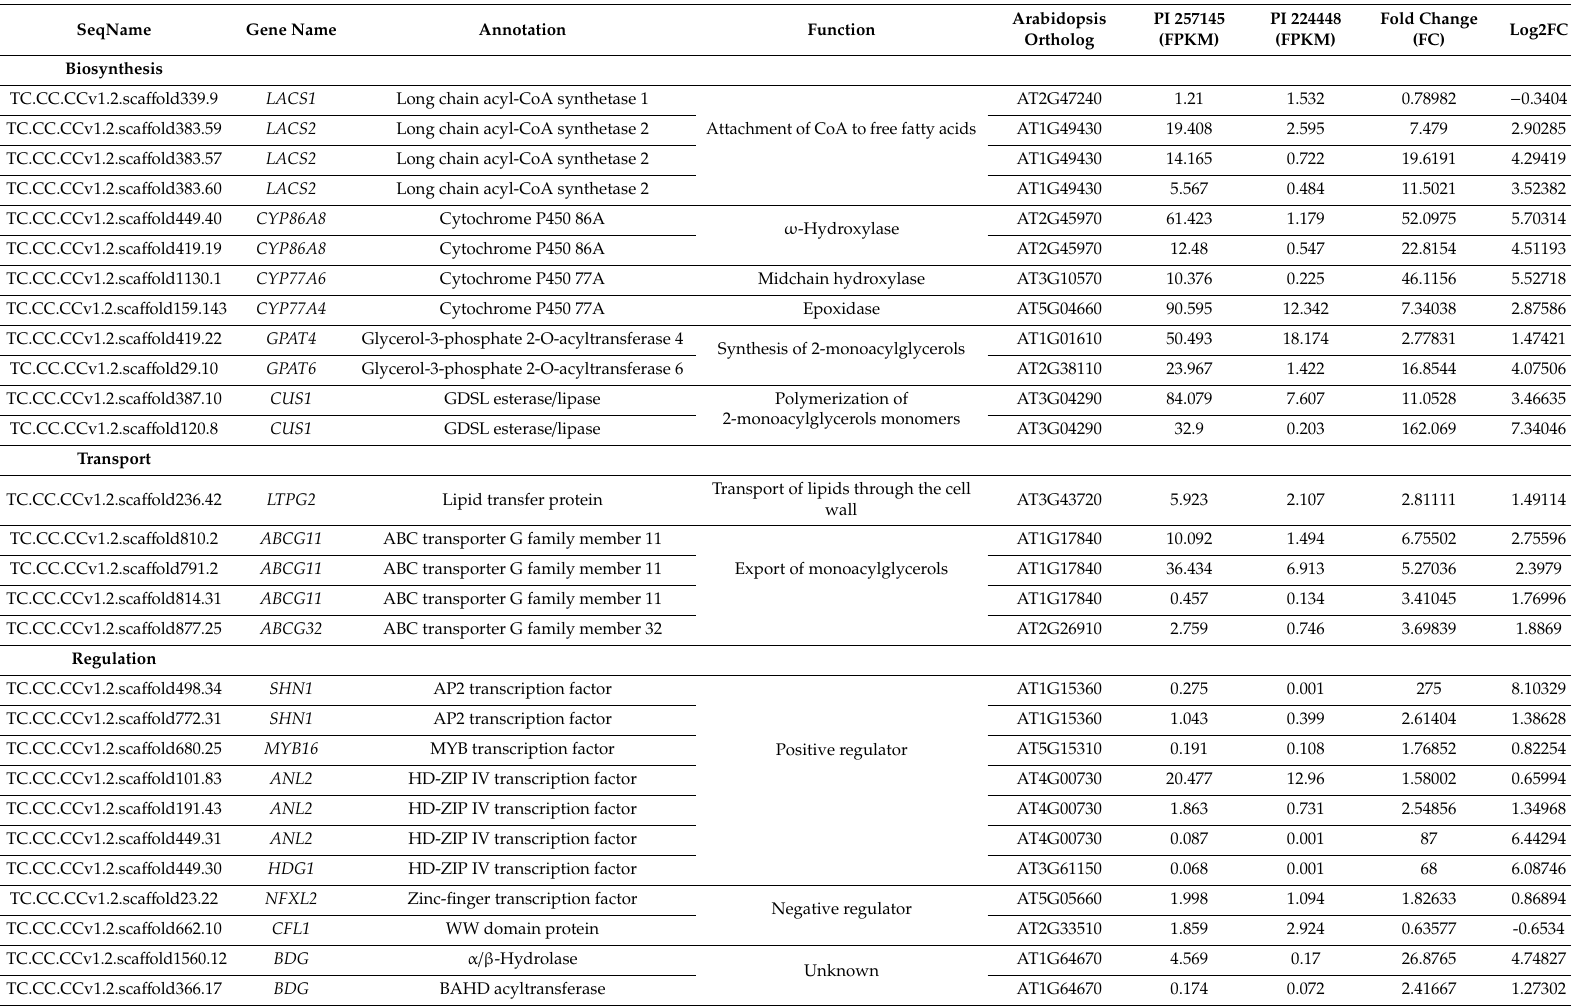
Table 4. Expression of genes and transcriptions factors involved in cutin biosynthesis identified from Capsicum chinense